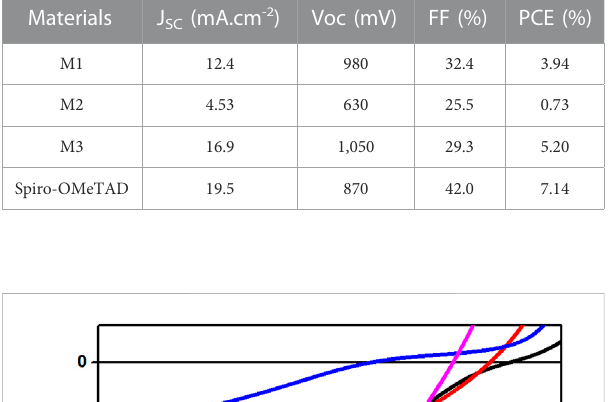
TABLE 3 HTM performances of M1-M3. Materials